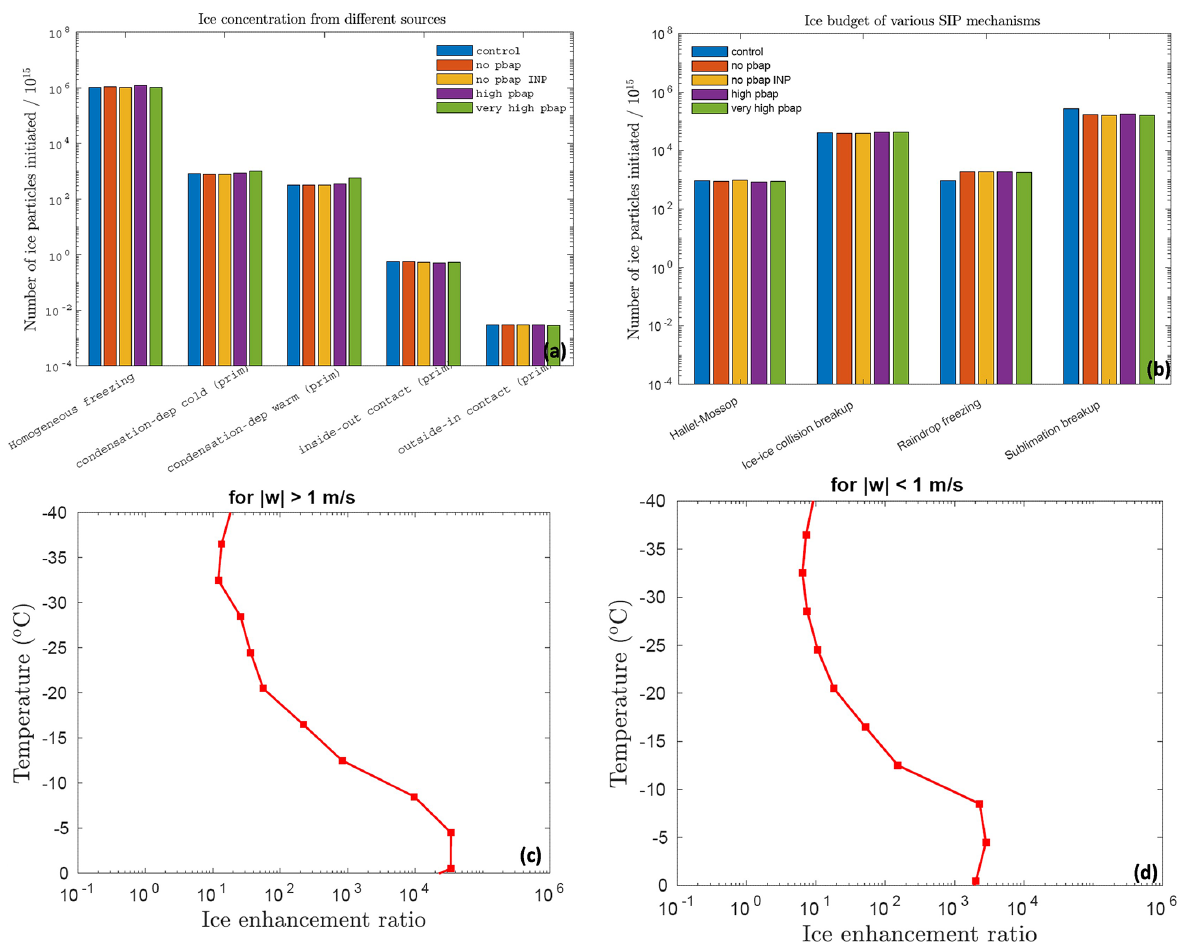
Figure 8. The number of ice crystals produced during the whole storm by (a) primary ice nucleation mechanisms and homogeneous freezing, and (b) various SIP mechanisms (as shown in the legend) per 10 15 particles are shown for various sensitivity runs. The ice enhancement ratio for the convective and stratiform regions is shown in panels (c) and (d)